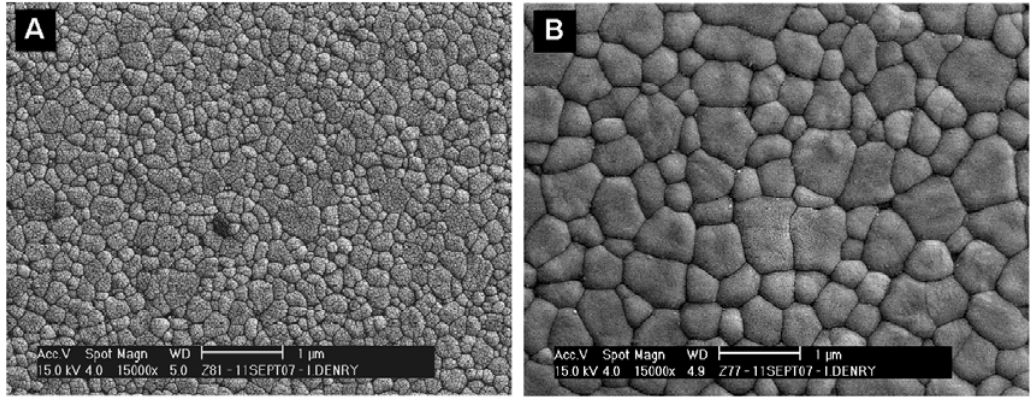
Figure 10. 3Y-TZP ceramic sintered at (a) 1300 °C for 2 hours and (b) 1500 °C for 2